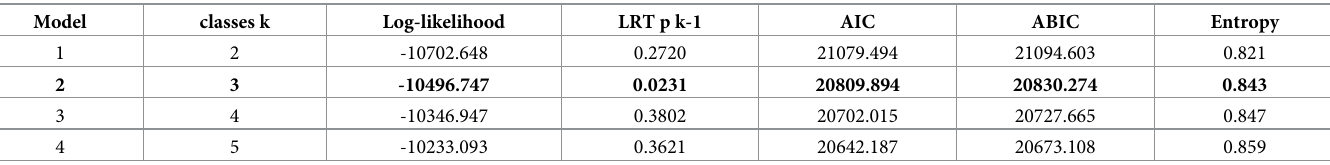
Table 2. Model fit parameter for the LPA model